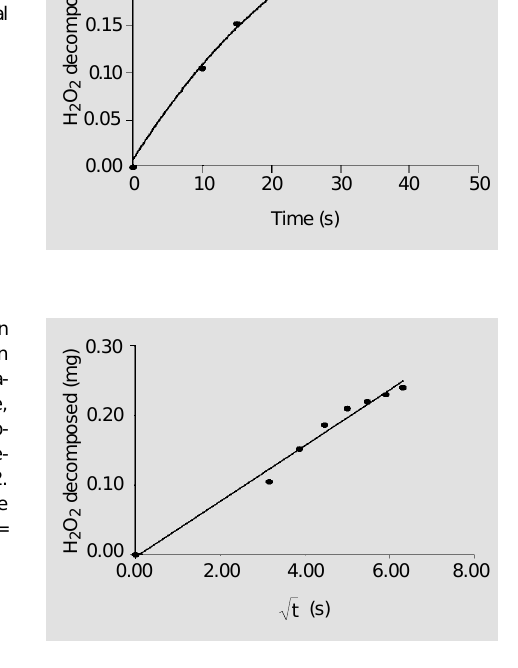
values for a parabola.